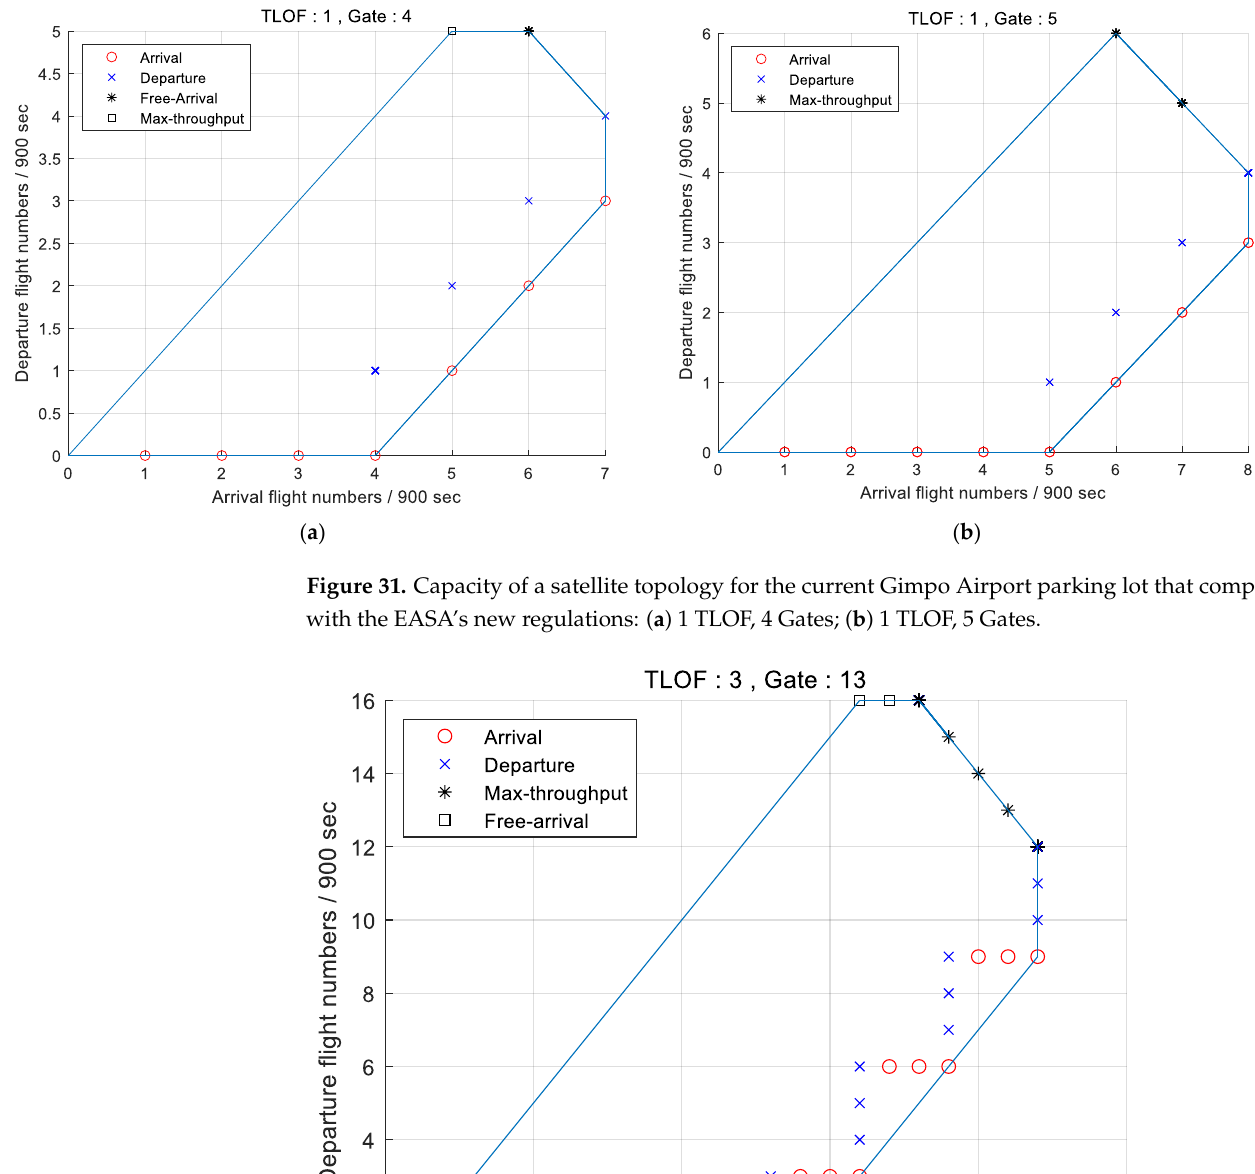
Figure 30. Capacity of a linear topology for the current Gimpo Airport parking lot that complies with the EASA’s new regulations.